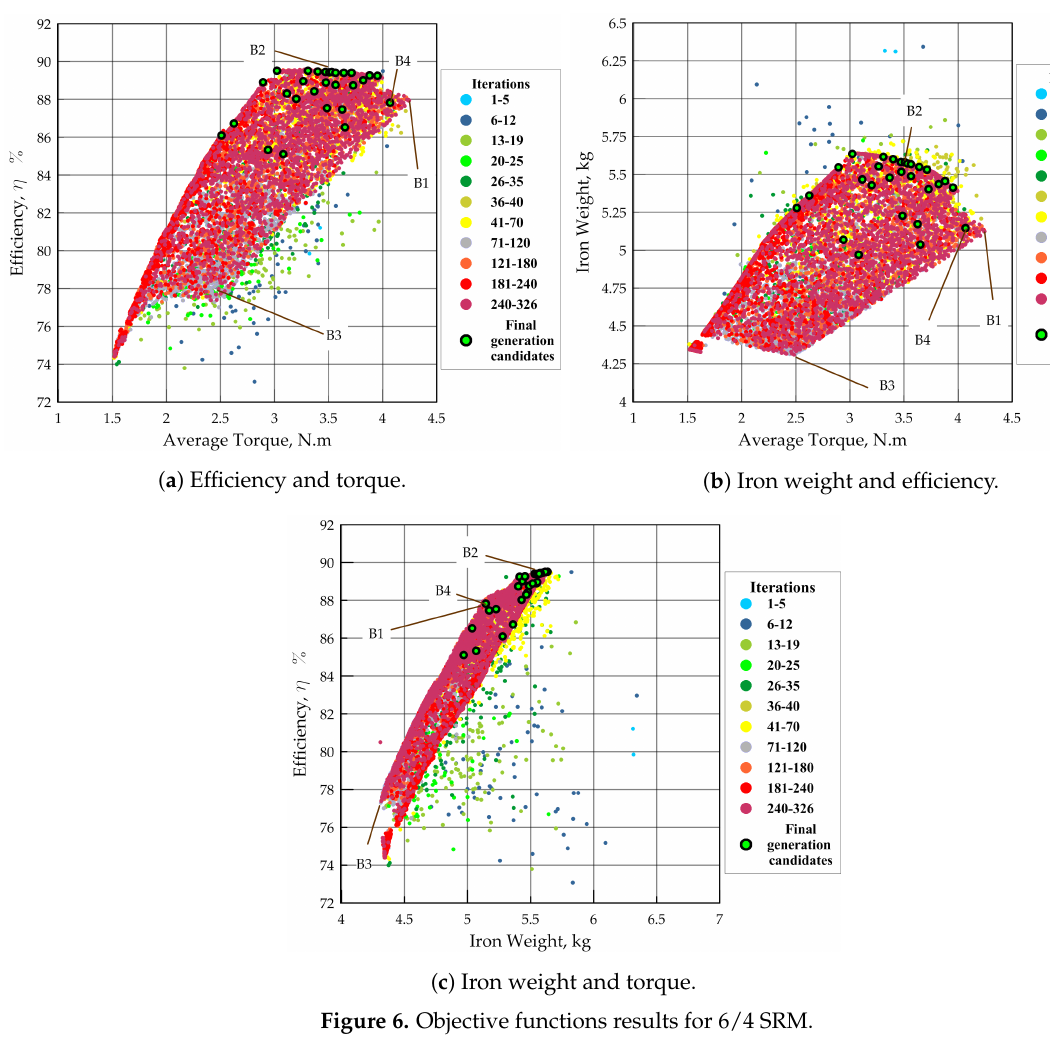
Figure 6. Objective functions results for 6/4 SRM.